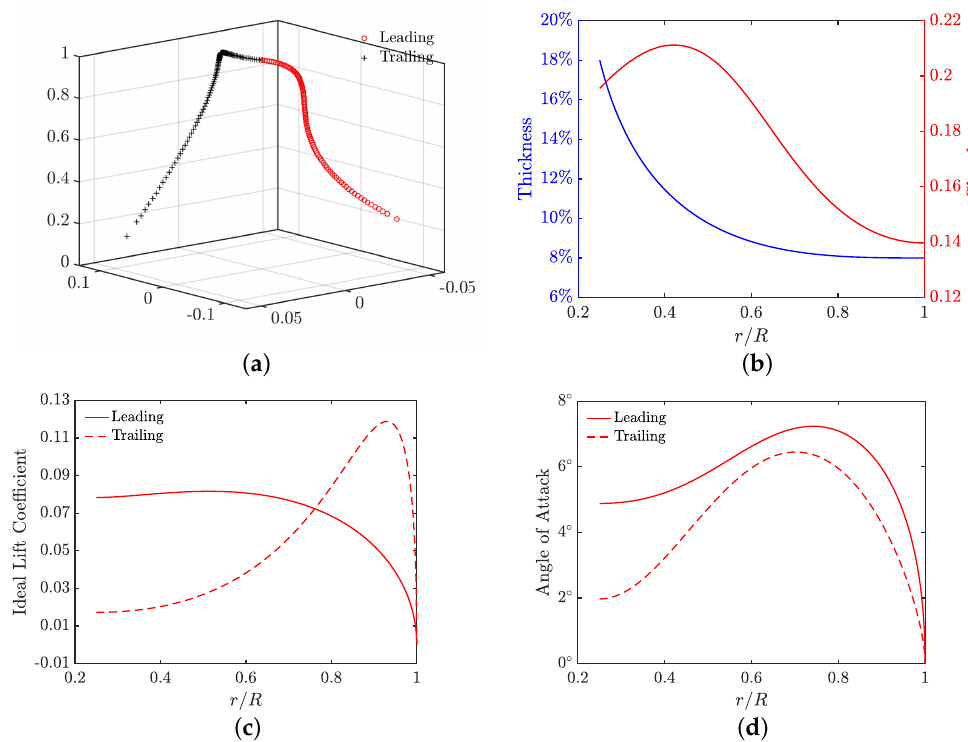
Figure 5. The sectional distributions of the parameters of the Boxprop dual-blade consisting of the leading and trailing sub-blades: ( a ) the stacking line, ( b ) the chord and thickness, ( c ) the ideal lift coefficient and ( d ) AOA as the sum of the pitch and helix